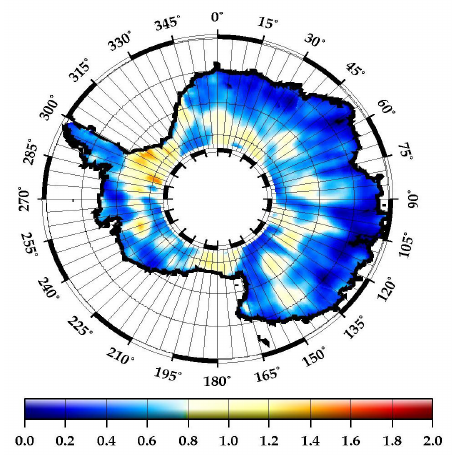
Figure 6. Difference in altimetric height between the Ku-band and the S-band of the altimeter from [22]. This map illustrates very well the effect of the penetration of the radar wave within the snow pack because it depends on the wave frequency. This map can also be used to derive the principal characteristics of the snow pack and of the surface